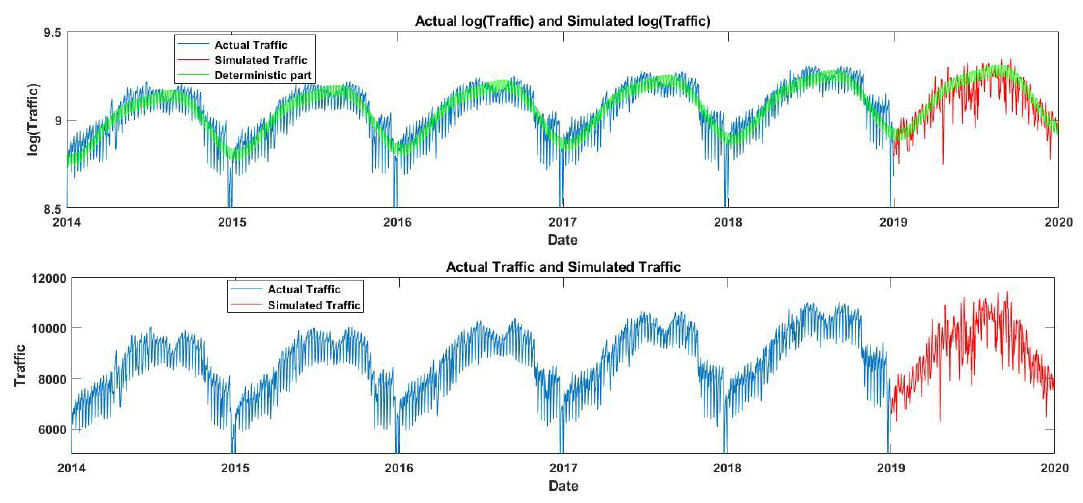
Figure 7. Historic number of flights and a simulated path of daily flights